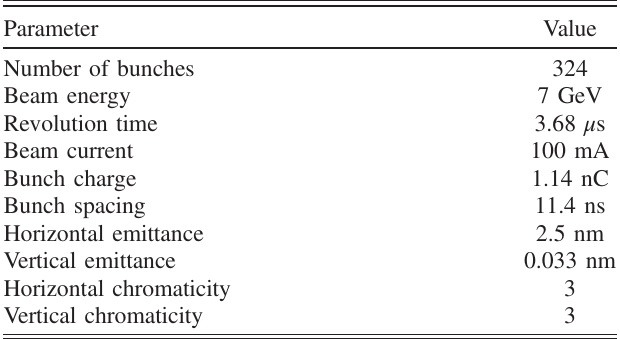
TABLE II. Nominal beam parameters for 324 bunch